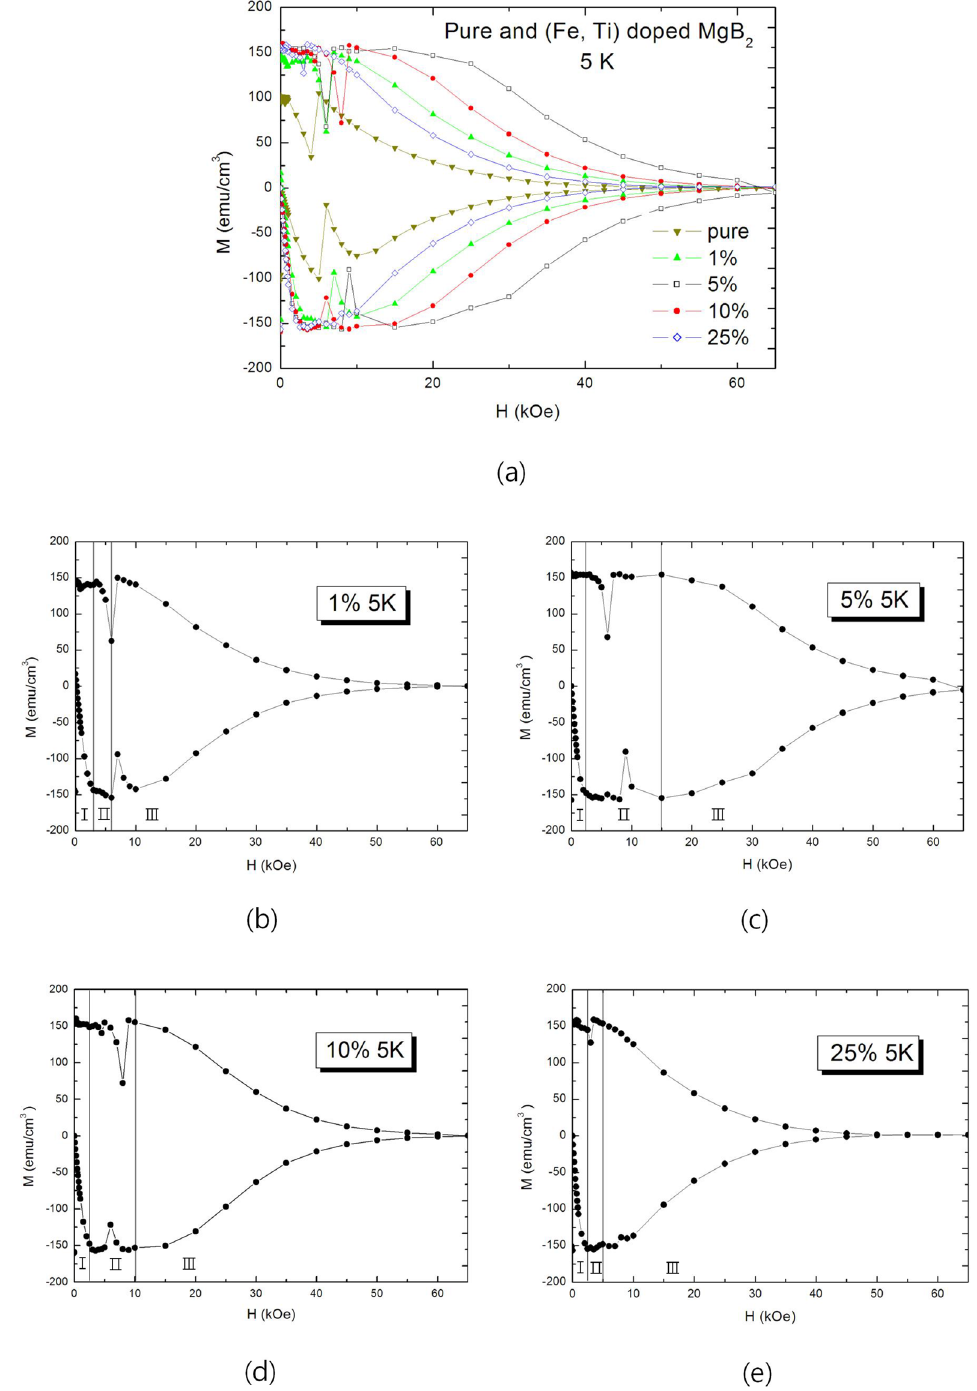
Figure 2. Field dependences of magnetizations (M-H curves) at 5 K of wt.% (Fe, Ti) particle-doped MgB 2 specimens, which was air-cooled. ( a ): M-H curves for comparison. ( b ): M-H curve of 1 wt.% (Fe, Ti) particle- doped MgB 2 . ( c ): M-H curve of 5 wt.% (Fe, Ti) particle-doped MgB 2 . ( d ): M-H curve of 10 wt.% (Fe, Ti) particle-doped MgB 2 . ( e ): M-H curve of 25 wt.% (Fe, Ti) particle-doped MgB 2 . Region I and Region II are extended (cid:31) H = (cid:31) B Region. Decision of a width of (cid:31) H = (cid:31) B regions of specimens was made by thinking over 1st and 2nd quadrants of M-H curve, and field dependence of magnetization at the same